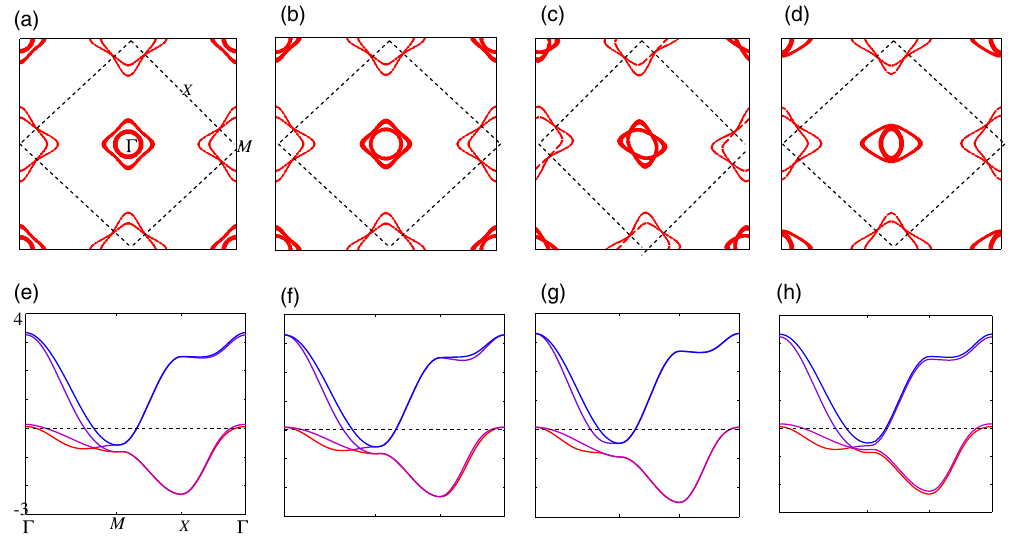
¼ 0 : 05 in Eq. (24); (d),(h) t bo